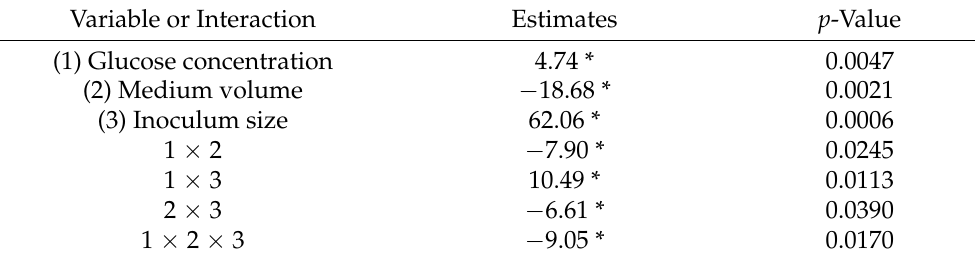
Table 2. Effects of the independent variables and their interactions on protease production by Aspergillus tamarii URM4634 in sequential fermentations carried out according to the 2 3 -full factorial design shown in Table 1 using wheat bran as a